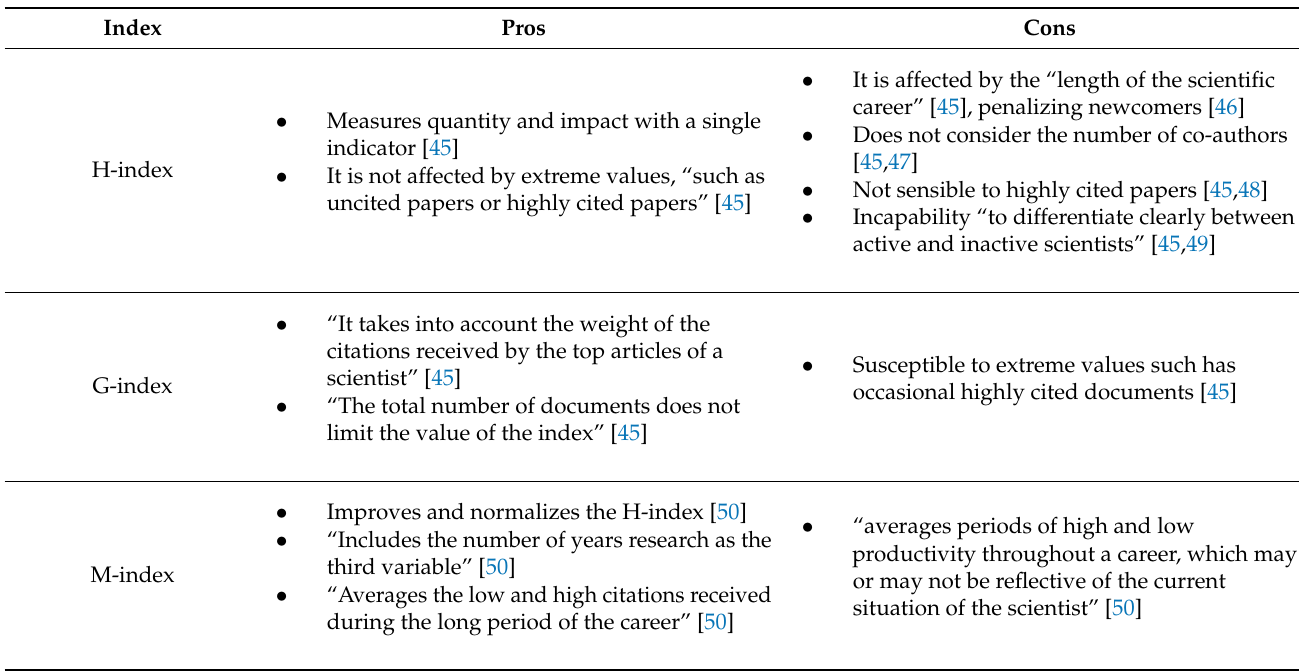
Table 5. Pros and Cons of H-index, G-index and